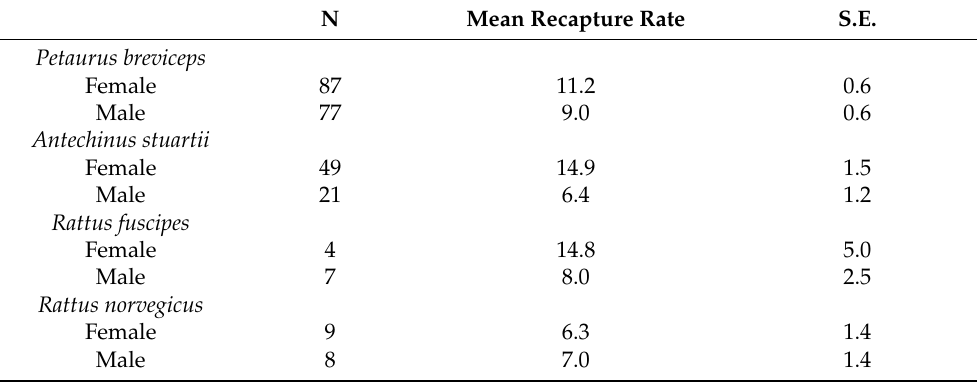
3% Table 2. Average rates of selfie trap recaptures for each individual (for those confidently sexed). Recaptures refer to the number of independent nightly observations (i.e. observations separated by 24 h), and includes observations where individuals were recorded at different sites during a single night. The current study performed 4592 camera trap nights in total, with each area (thus each individual) camera trapped for 28 nights. N Mean Recapture Rate